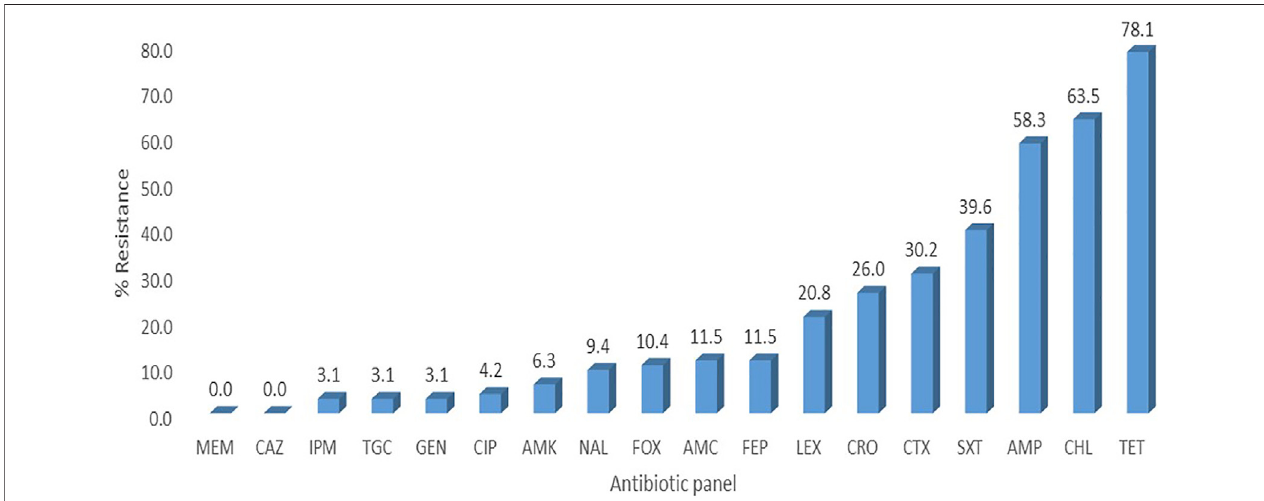
FIGURE 1 | Percentage resistance of the E. coli isolates. LEX-Cefalexin, FEP-Cefepime, CTX-Cefotaxime, CAZ-Ceftazidime, AMP-Ampicillin, FOX-Cefoxitin, TGC-Tigecycline, CIP-Cipro fl oxacin, TET-Tetracycline, SXT- Trimethoprim-sulfamethoxazole, AMC-Amoxicillin-clavulanic acid, CHL- Chloramphenicol, GEN- Gentamicin, AMK- Amikacin, MEM-Meropenem, CRO-Ceftriaxone, IPM-Imipenem, NAL-Nalidixic acid.